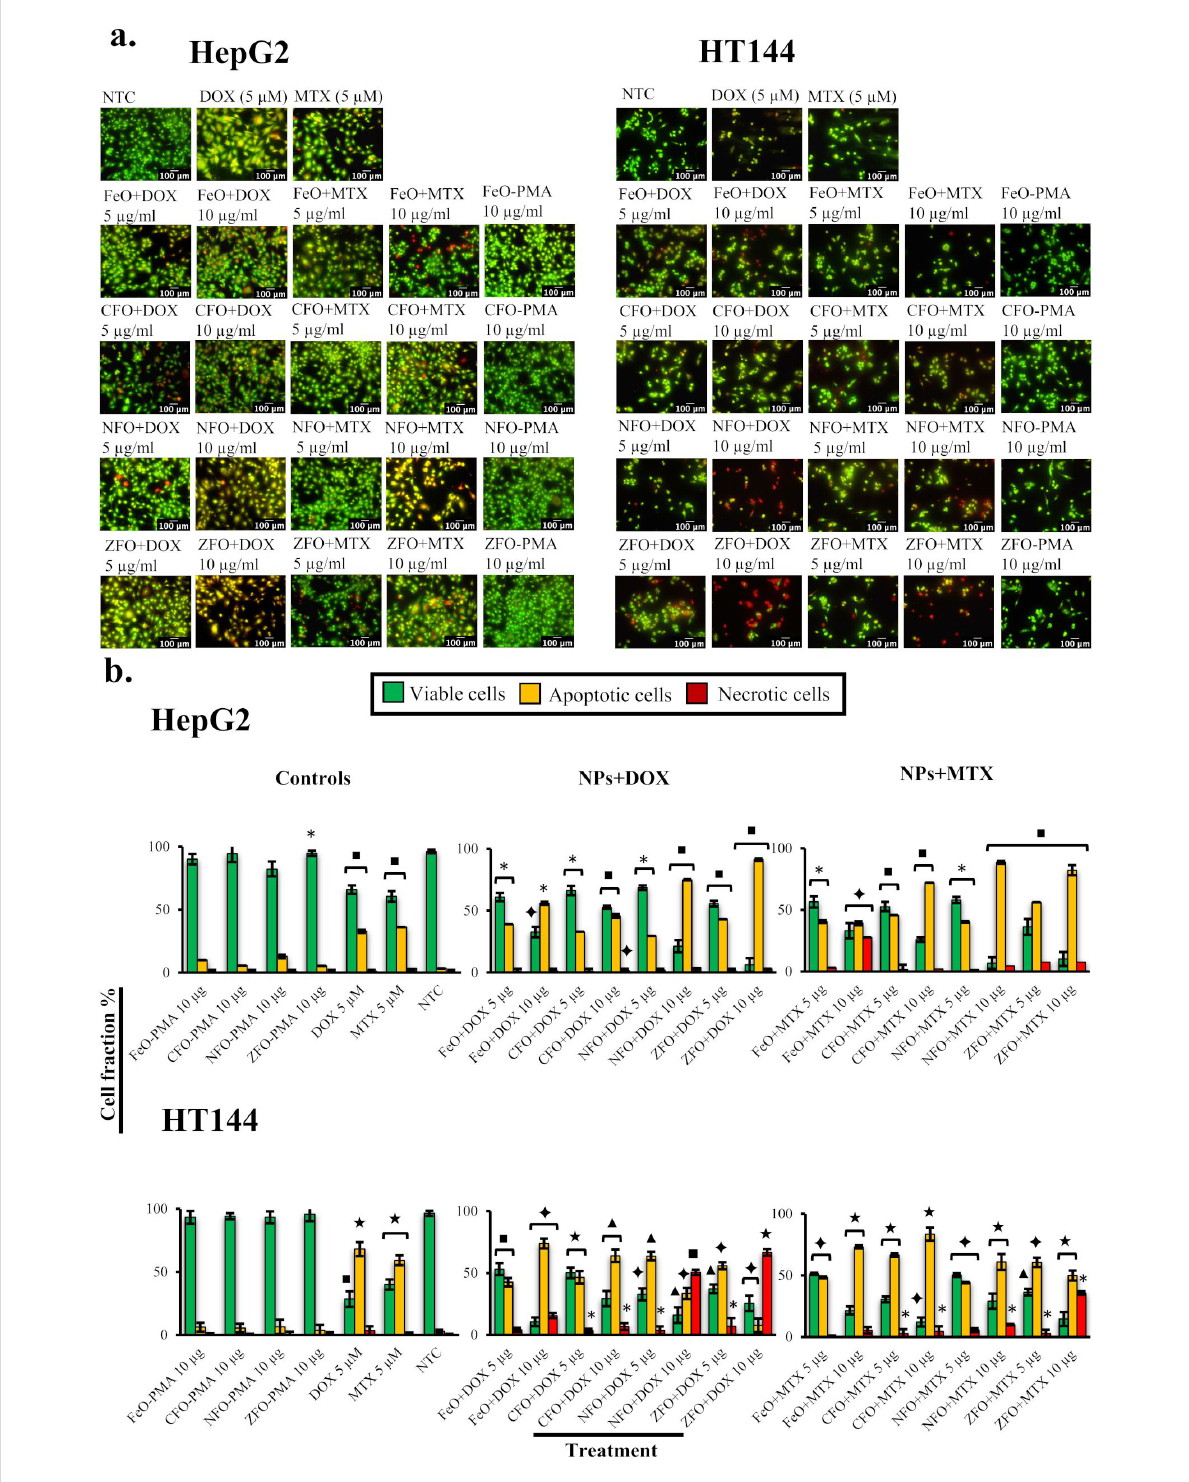
Figure 5: (a) Fluorescence microscopy images of HepG2 and HT144 cells upon treatment with drug-loaded (DOX and MTX) MFe 2 O 4 (M = Fe, Co, Ni, Zn) NPs at 5 and 10 μ g/mL for 3 h. Controls included free drugs (DOX and MTX, 5 μ M), NPs-PMA (10 μ g/mL), and NTC. Live cells are shown in green, necrotic cells are shown in red, and apoptotic cells are shown in yellow to orange range due to AOPI staining. Magnification = 200×, scale bar = 100 μ m. (b) Quantitative analysis of the percentage of viable, apoptotic, and necrotic cells (mean ± SD of experimental triplicates) in treated HepG2 and HT144 cells in comparison to controls. p < 0.05 (one asterisk), p < 0.01 (black square symbol), p < 0.005 (black diamond symbol), p < 0.001 (black star symbol), and p < 0.0005 (black triangle symbol), two-tailed t -test when samples were compared to